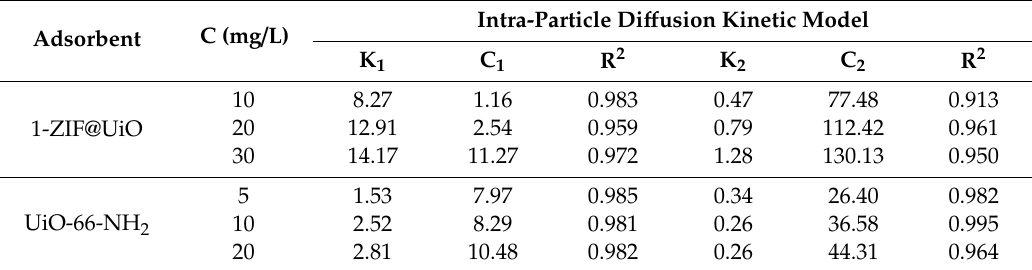
Table 5. Parameters of intra-particle di ff usion kinetic model.